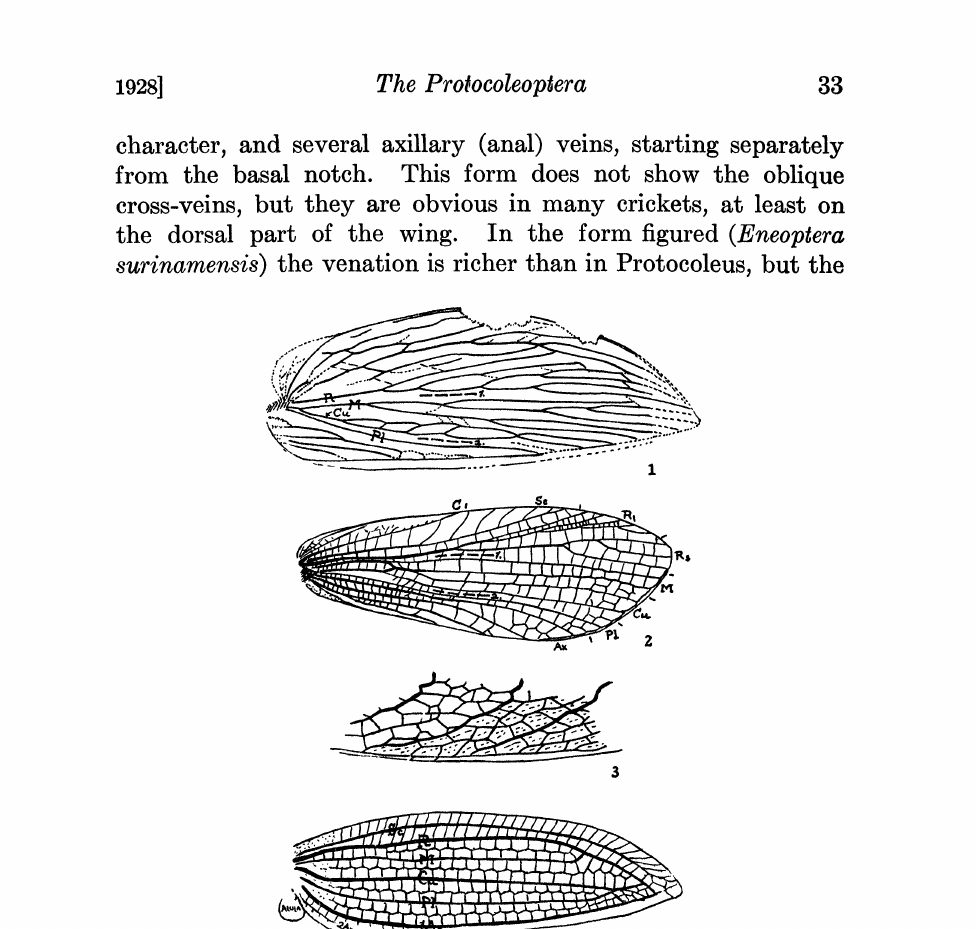
Fig. 1. 1, Protocoleus,, mainly after Tillard’s photograph, (P1. 46), sup- plemented by his restoration (fig. 3, p. 432); 2, Gryllacris (Orthoptera, Gryllacrididm); fore wing; 3, Eneoptera surinamensis (Orthoptera, Gryllide); portion of inner margin of fore wing; 4, Venation of Coleopterous elytron, synthesized mainly from venation of Cupes and tracheation of